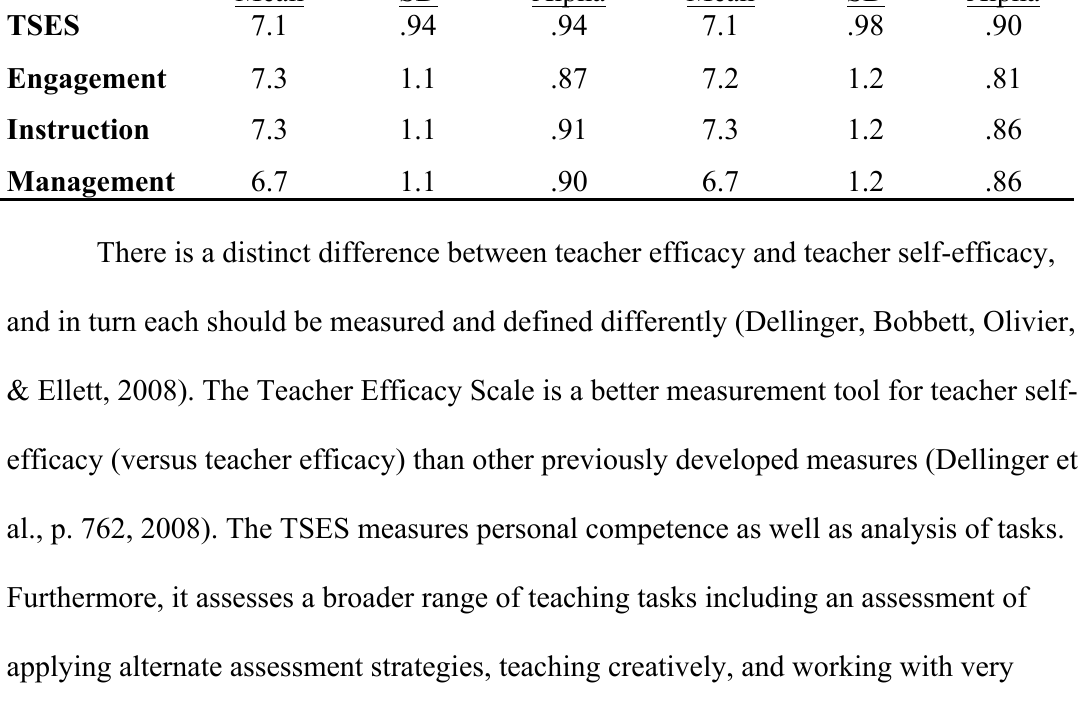
Reliabilities of TSES Long Form Short Form Mean SD Alpha Mean SD Alpha TSES